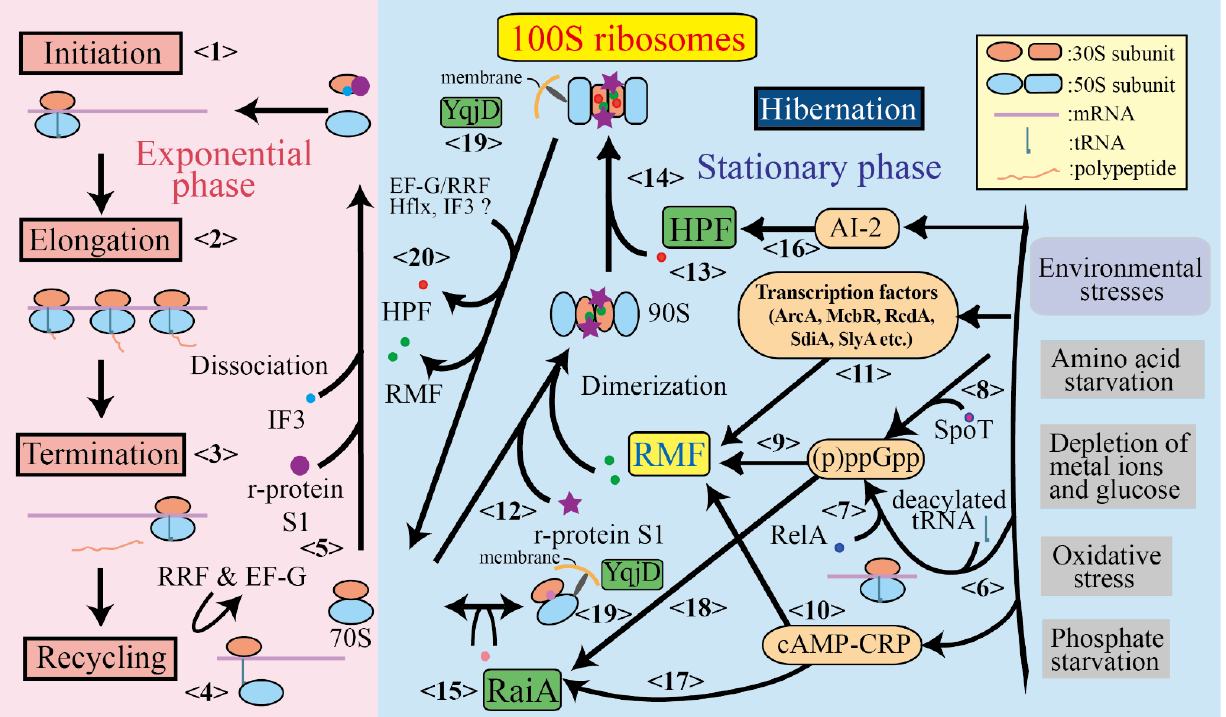
Figure 2. Ribosome cycle including the hibernation stage and expression pathways of factors related to formation of 100S ribosome in Escherichia coli . The state of ribosomes in the exponential phase, when cell proliferation is active, and in the stationary phase, when cells are under stress, are shown. The currently known expression pathways of RMF, HPF, and RaiA, factors involved in the formation of the 100S ribosome, are